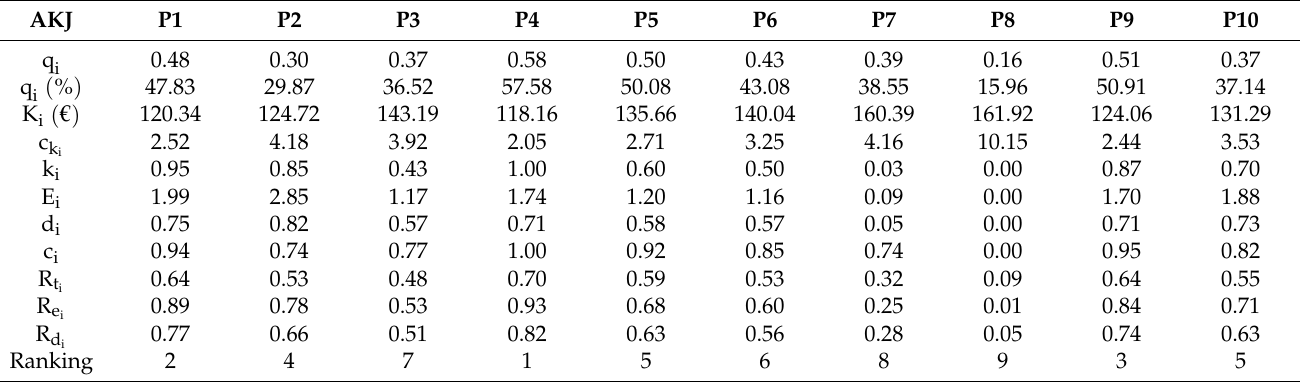
Table 10. Qualitative ‐ cost analysis for photovoltaic panels.